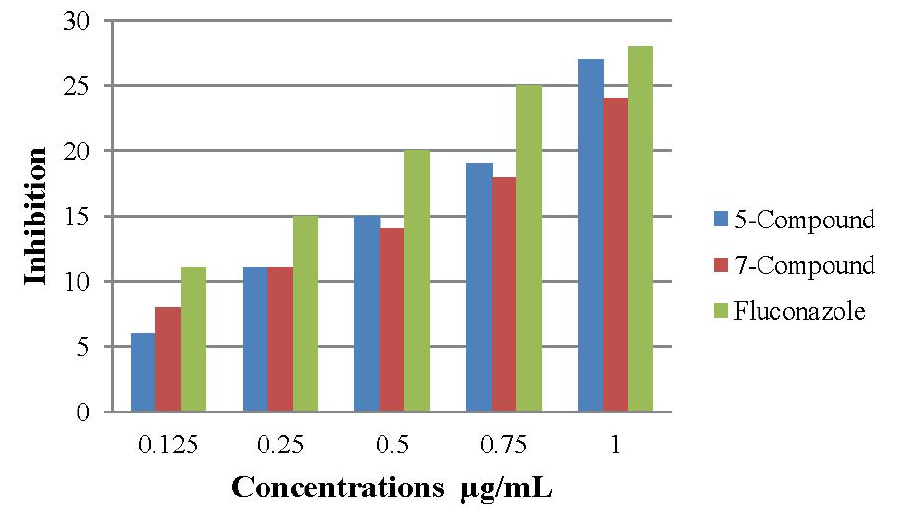
Figure 4. The effect of compounds 5 and 7 towards the tested organism Aspergillus niger